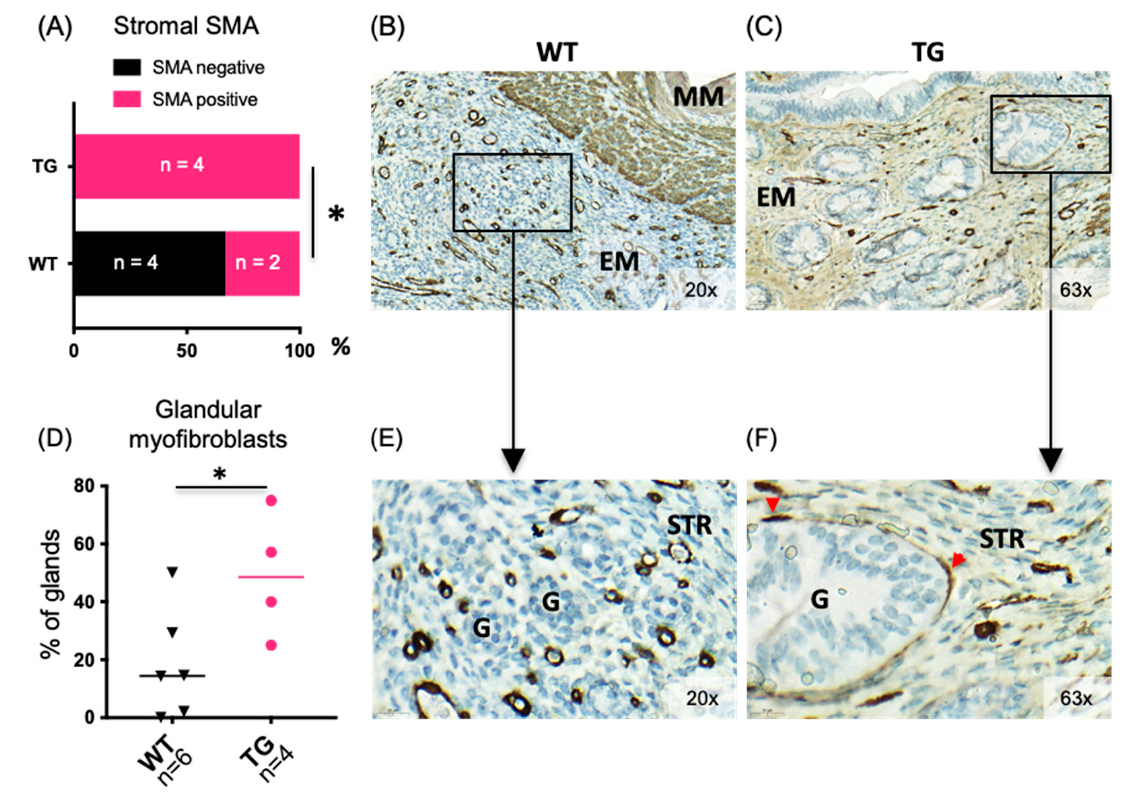
Figure 1. Uterine changes preceding the adenomyosis phenotype in HSD17B1TG females. At the age of four months, HSD17B1TG uterus showed changes related to mechanical stress and increased exposure to estrogens. ( A ) The endometrial stromal cells appeared more positive for smooth muscle actin (SMA), as shown by representative images of immunohistochemical SMA analysis for WT ( B ) and HSD17B1TG ( C ) uteri. Higher magnifications (of the areas indicated by black squares in ( B , C ) are shown in ( E , F ), respectively. ( D ) The endometrial glands in HSD17B1TG mice were surrounded by myofibroblast cells significantly more often than in WT mice. The SMA-positive myofibroblasts are shown by the red arrowheads in ( F ). * p < 0.05, MM = myometrium, EM = endometrium, G = gland, STR = stroma, triangle = WT, circle = TG.